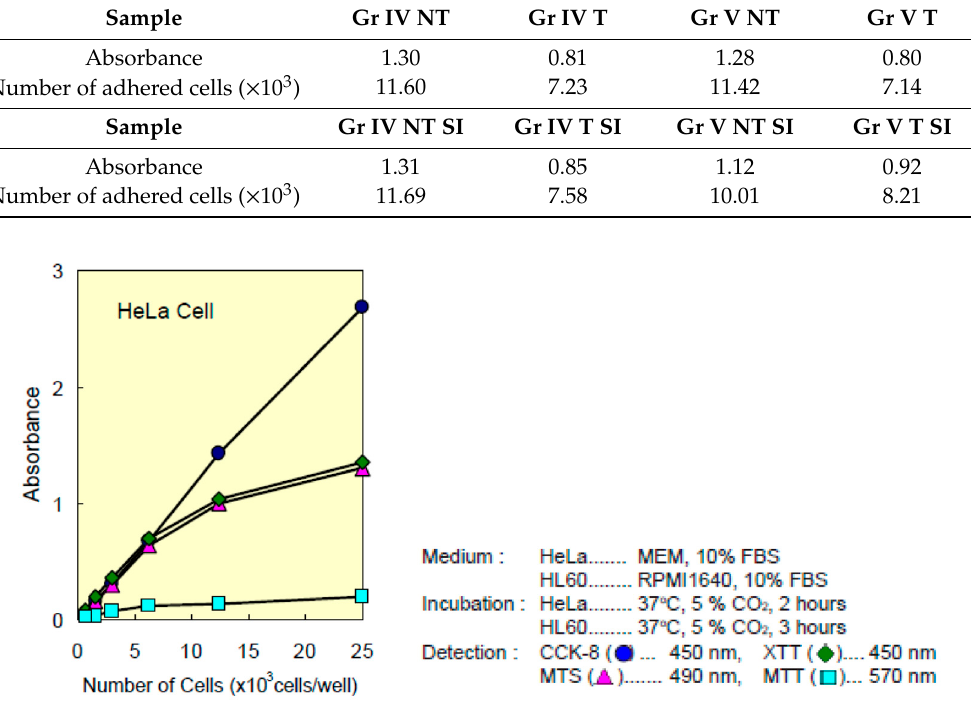
Figure 15. Representation of the number of HeLa cells with regard to absorbance. It is found that 1 OD are 8.93 × 10 3 HeLa cells (blue circle). This has been the relationship we have used to extrapolate the absorbance obtained with the number of cells present.